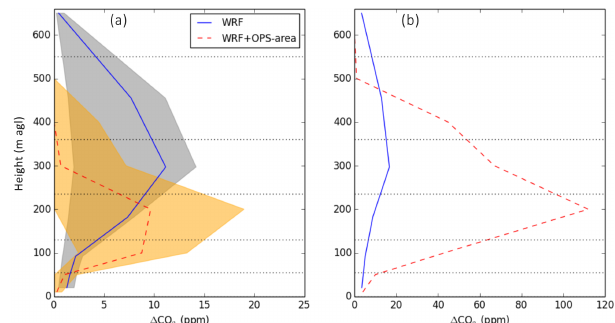
Figure 6. Vertical profiles of the median (Q1–Q3) (a) and maxi- mum (b) (cid:49) CO 2 mixing ratio at 14:00UTC at about 500m from an energy production point source in WRF-Chem and WRF + OPS- area. The horizontal lines represent the boundaries of the vertical levels in WRF-Chem. Emissions are taking place in levels 3, 4 and 5 in WRF-Chem or at 130, 235 and 360m in WRF + OPS- area. The figure shows on average lower mixing ratios at ground level in WRF + OPS-area than in WRF-Chem, despite an identi- cal treatment of the vertical emission structure. WRF + OPS-area also shows higher maximum values, reflecting a reduction in verti- cal dispersion compared to the Eulerian box representation in WRF-